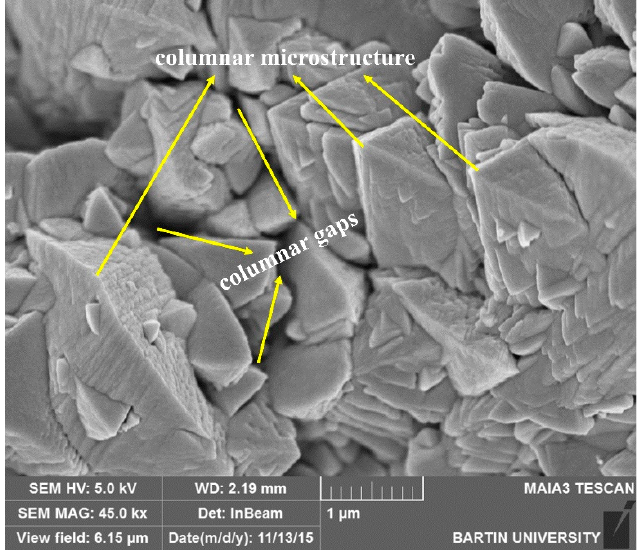
Figure 2. As-deposited columnar surface image micrograph of microstructure of YSZ TBC. Table 2. Hardness values of the thermal barrier coating component.